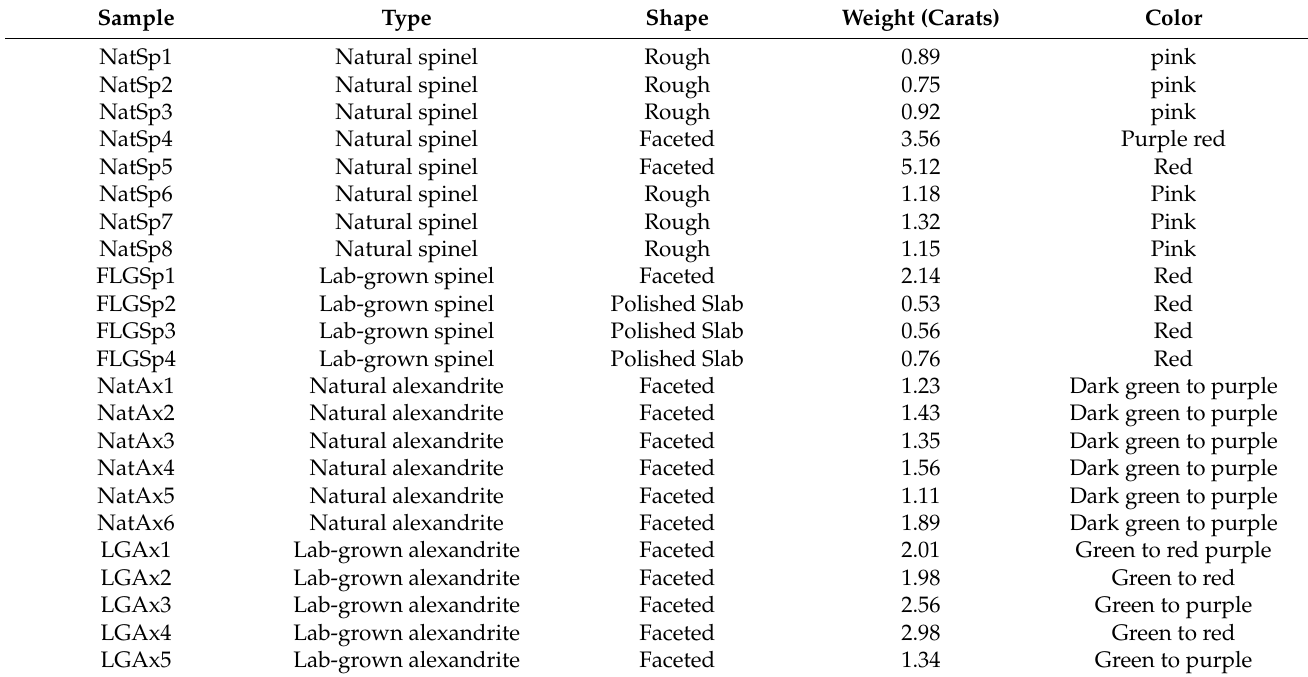
Table 1. List of the selected spinel and alexandrite